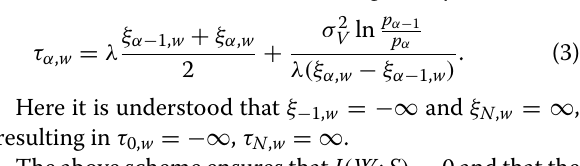
The Rec algorithm computes the estimator ˆ s as the value in S for which it holds that y ∈ (τ ˆ s , w , τ ˆ s + 1, w ) , where the parameters τ are decision boundaries. In the case of Gaussian noise these boundaries are given by